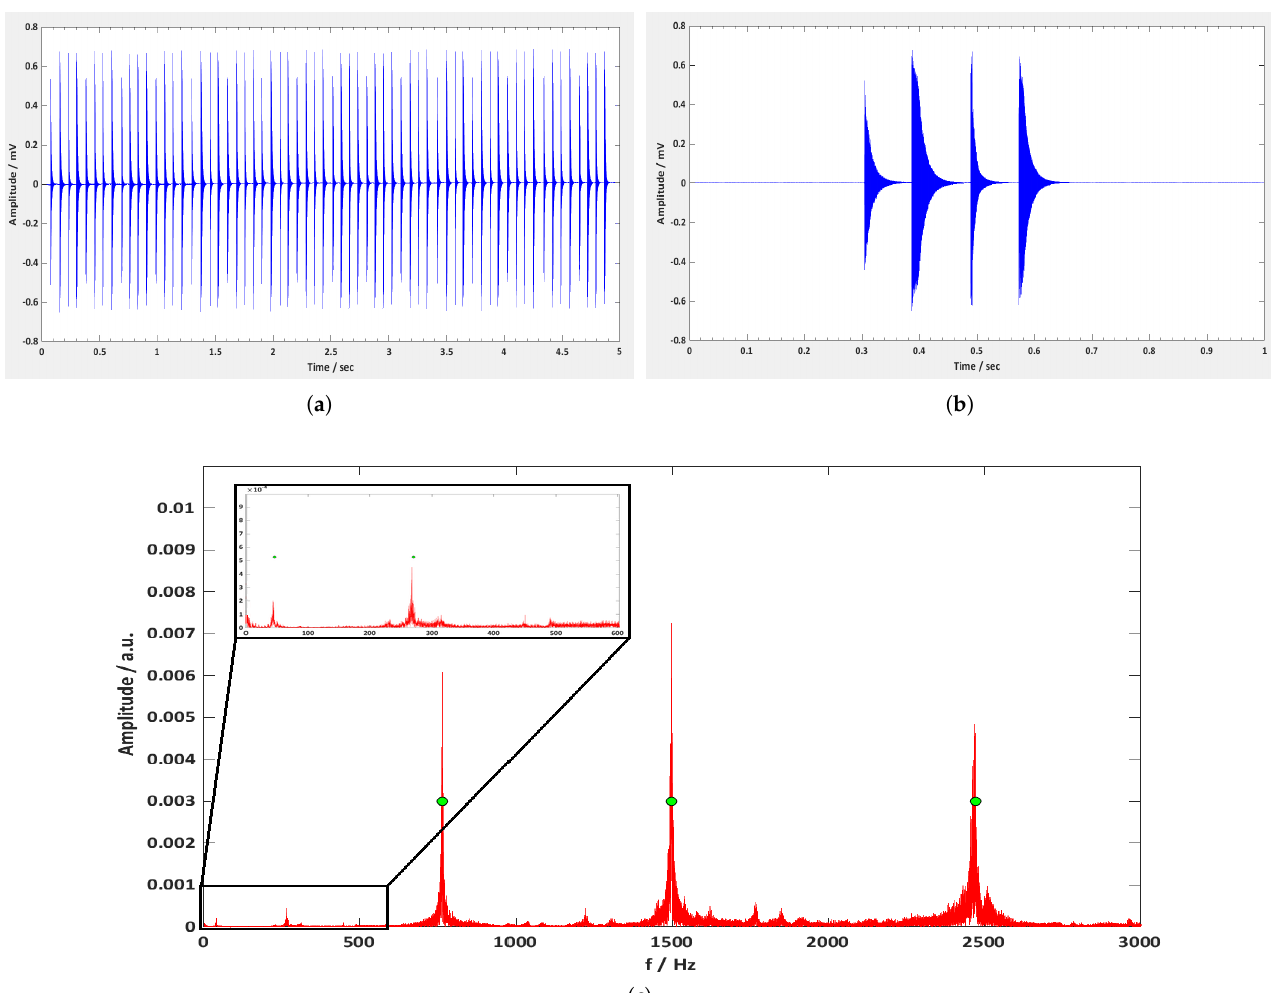
Figure 7. ( a ) Excitation signal of the undamaged rotating blades versus time. ( b ) Excitation signal for one rotation only. ( c ) FFT spectrum of the 1st undamaged rotating blade. The green circles indicate the frequency values of the first 5 bending modes of the undamaged blade as they were calculated by ANSYS modal